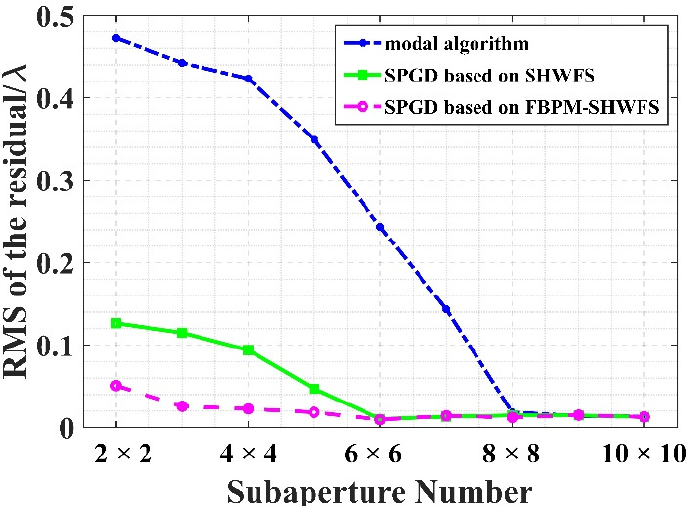
9 of 14 Figure 9. Results of wavefront reconstruction for three methods with different subaperture numbers. Figure 10 shows the statistical results of the RMS of 80 sets of residual wavefronts. When the number of subaperture is less than 8 × 8, the average slope information within subapertures cannot accurately represent the wavefront. This leads to the inability of the modal algorithm to effectively reconstruct the wavefront. However, the accuracy of the modal algorithm improves rapidly as the spatial frequency increases. As expected, the RMS of residual wavefront of the FBPM-SHWFS remains lower than those of the two